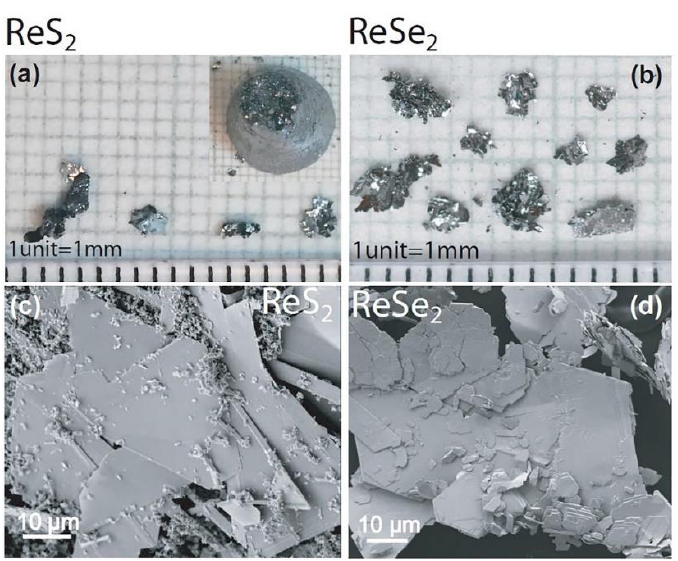
Figure 9. Optical image of the as-grown crystals of ( a ) ReS 2 (inset shows the ingot as removed from the quartz tube) and ( b ) ReSe 2 . SEM images of ( c ) ReS 2 and ( d ) ReSe 2 , showing the surface morphology of the flakes. Reprinted with permission from ref. [98]. Copyright 2016 American Chemical Society.